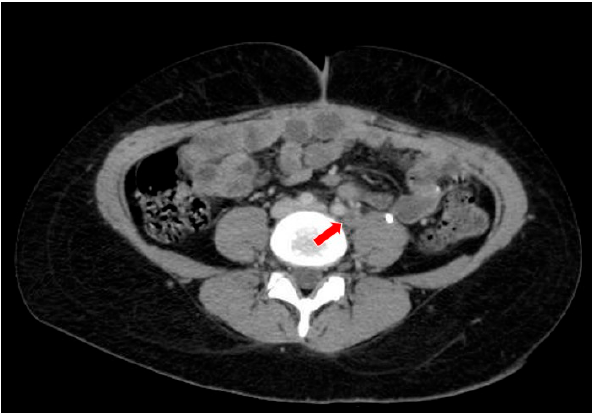
Figure 7. The computed tomography study in the portal phase showing a lymph node in the left iliac chain with a rounded aspect and a necrotic center (red arrow), suggestive of secondary neoplastic involvement (relapse).